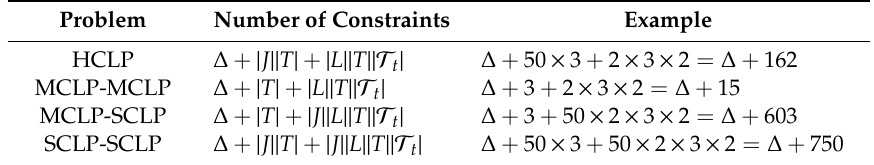
Table 8. Comparing total number of constraints in HCLP, MCLP-MCLP, MCLP-SCLP, and